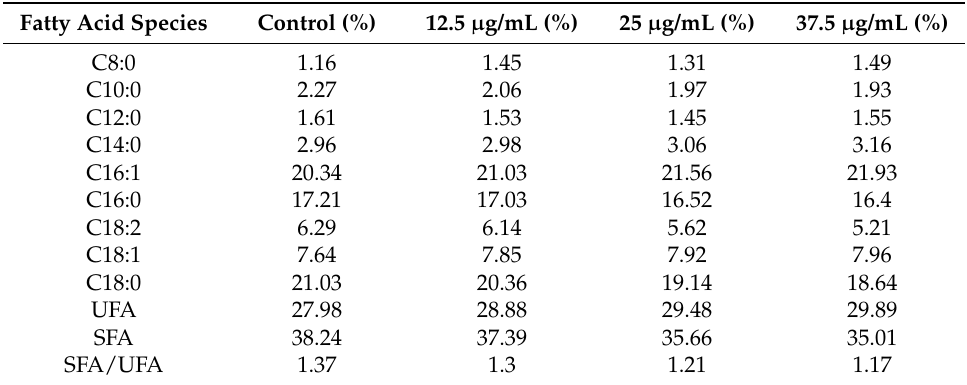
Figure 2. Indicators of damage to Staphylococcus aureus after treatment with juglone. A – C show changes in total superoxide dismutase (SOD) activity, total catalase (CAT) activity, and malondialdehyde (MDA) content, respectively; D , E show changes in DNA and RNA fluorescence intensity, detected at 364 nm and 400 nm; F shows changes in the peptidoglycan content. Error bar indicates SEM. Table 2. Fatty acid composition of the Staphylococcus aureus cell membrane following treatment with juglone for 2 h.